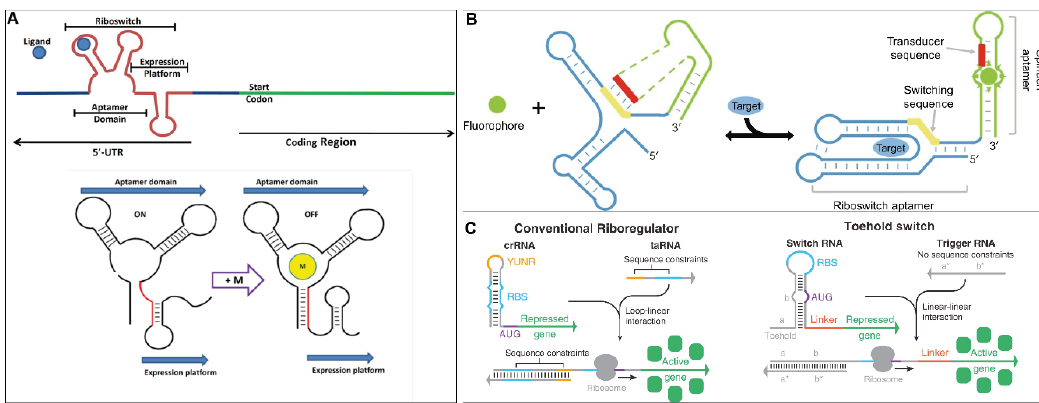
Figure 1. Schematics of the operating principles of a conventional riboswitch ( A ) [11] and the RNA- Figure1. Schematicsoftheoperatingprinciplesofaconventionalriboswitch( A